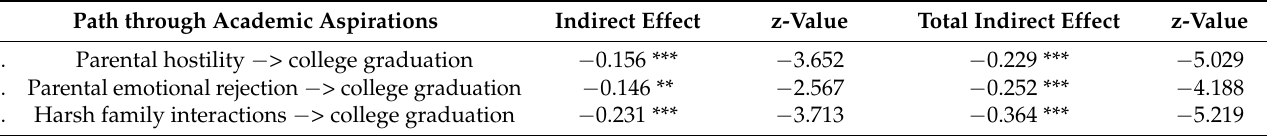
Table 5. Mediated effects of academic aspirations of immigrant youths in late adolescence on the rela- tionships between parental hostility, emotional rejection, and harsh family interactions with parents in early adolescence of immigrant youths and their successful college graduation in young